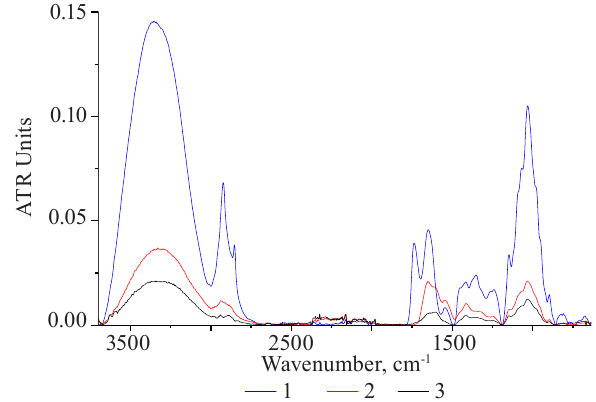
Sample E 1.49 Figure 8 IR-spectra of polysaccharide products: (1) dry amorphous extract, (2) PS-complex, (3) sample D, Table